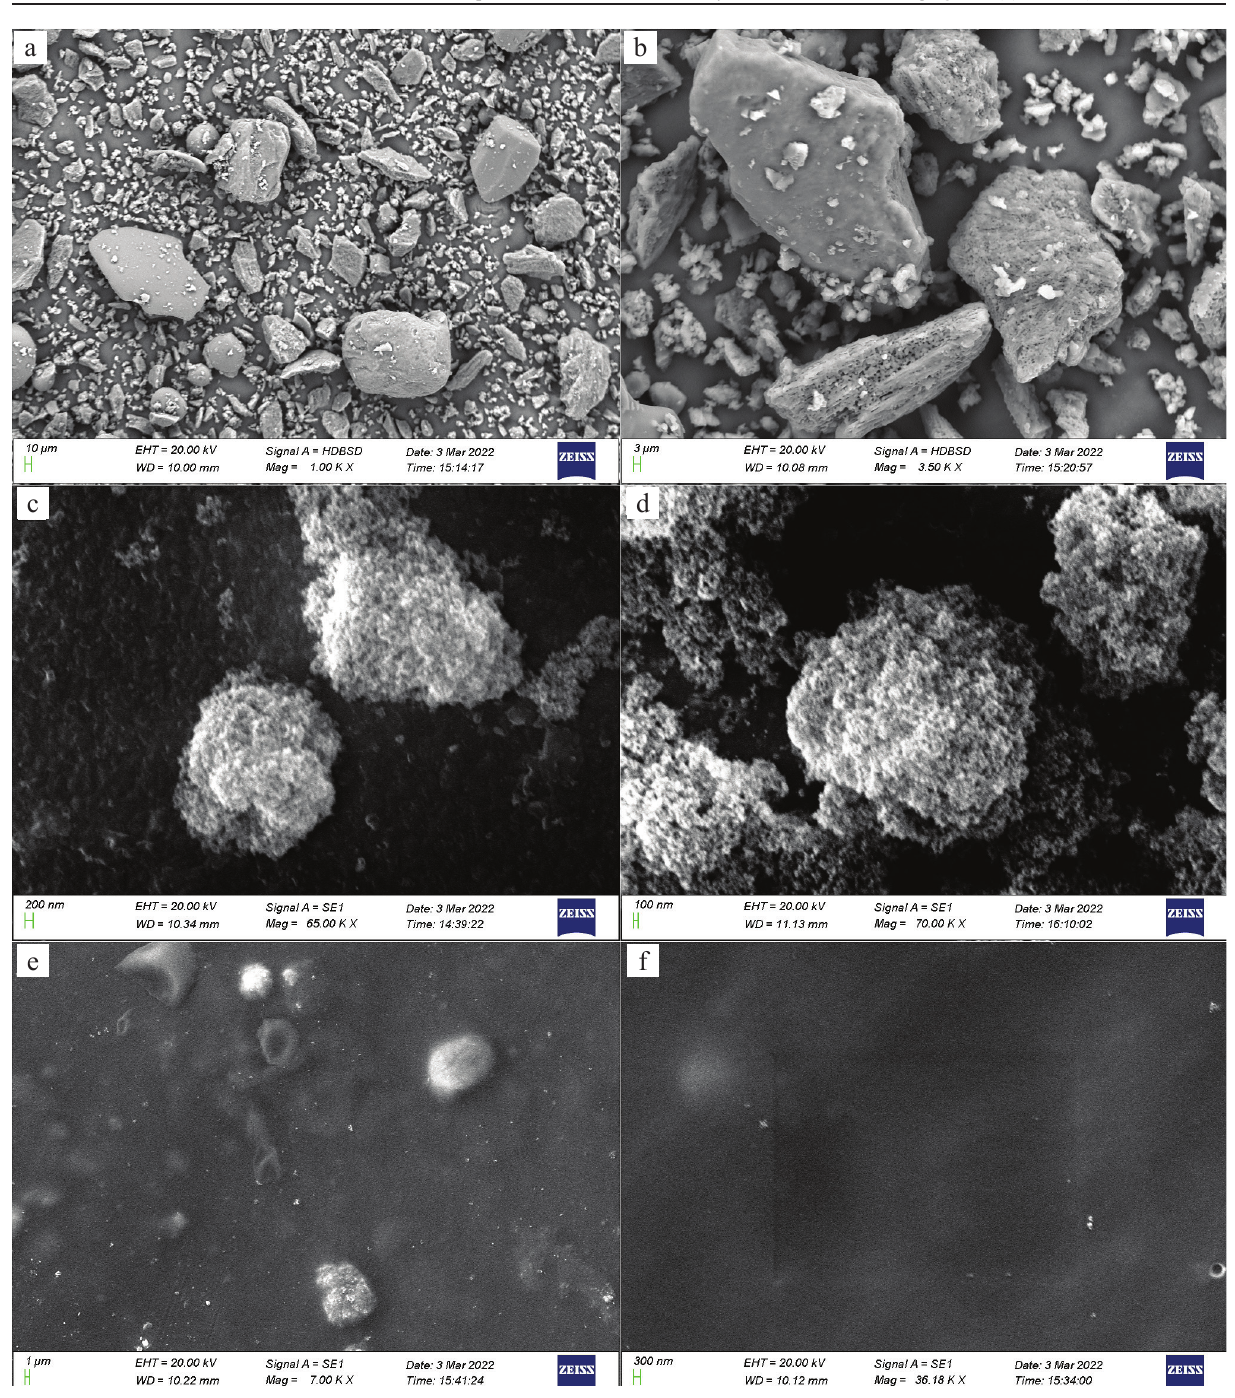
Fig. 2 – SEM image of pure valsartan (a, b), pure Aerosil 200 (c, d), film with Aerosil 200 (VA1) (e), and without Aerosil 200 (VA0)